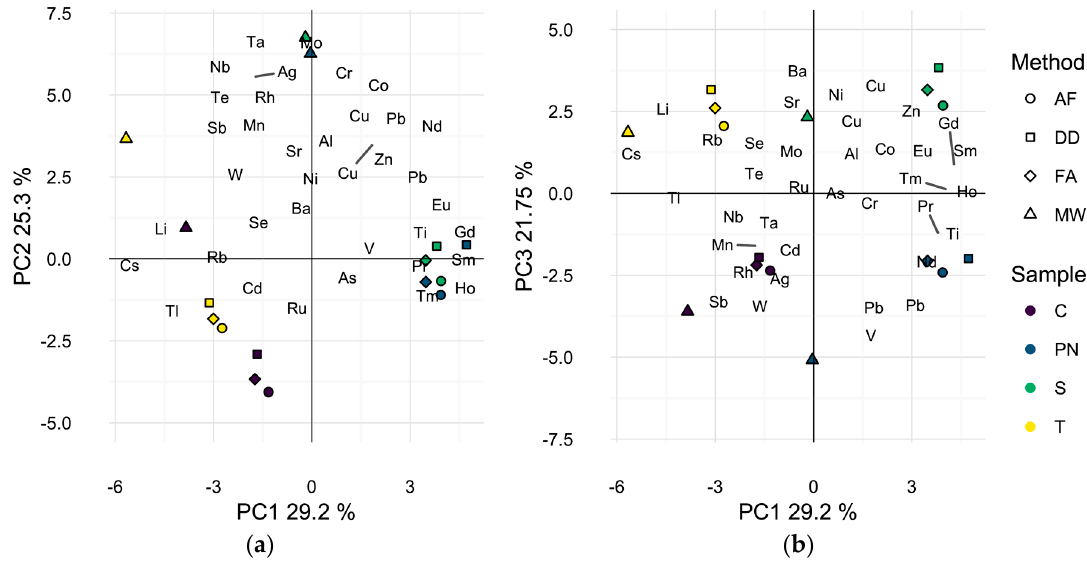
Figure 1. Principle component analysis biplot of wine sample scores and analytes found to differ significantly by preparation method. ( a ) First two dimensions (54.5% of total variance); ( b ) first and third dimensions (51.0% of total variance). Symbols represent different preparation methods: acidification prior to filtration (AF = ○ ); direct dilution (DD = □ ); filtration prior to acidification (FA = ◊ ); microwave digestion (MW = △ ). Wine varieties are color-coded: Chardonnay (C = purple), Pinot noir (PN = blue), Syrah (S = green), and Tempranillo (T = yellow).